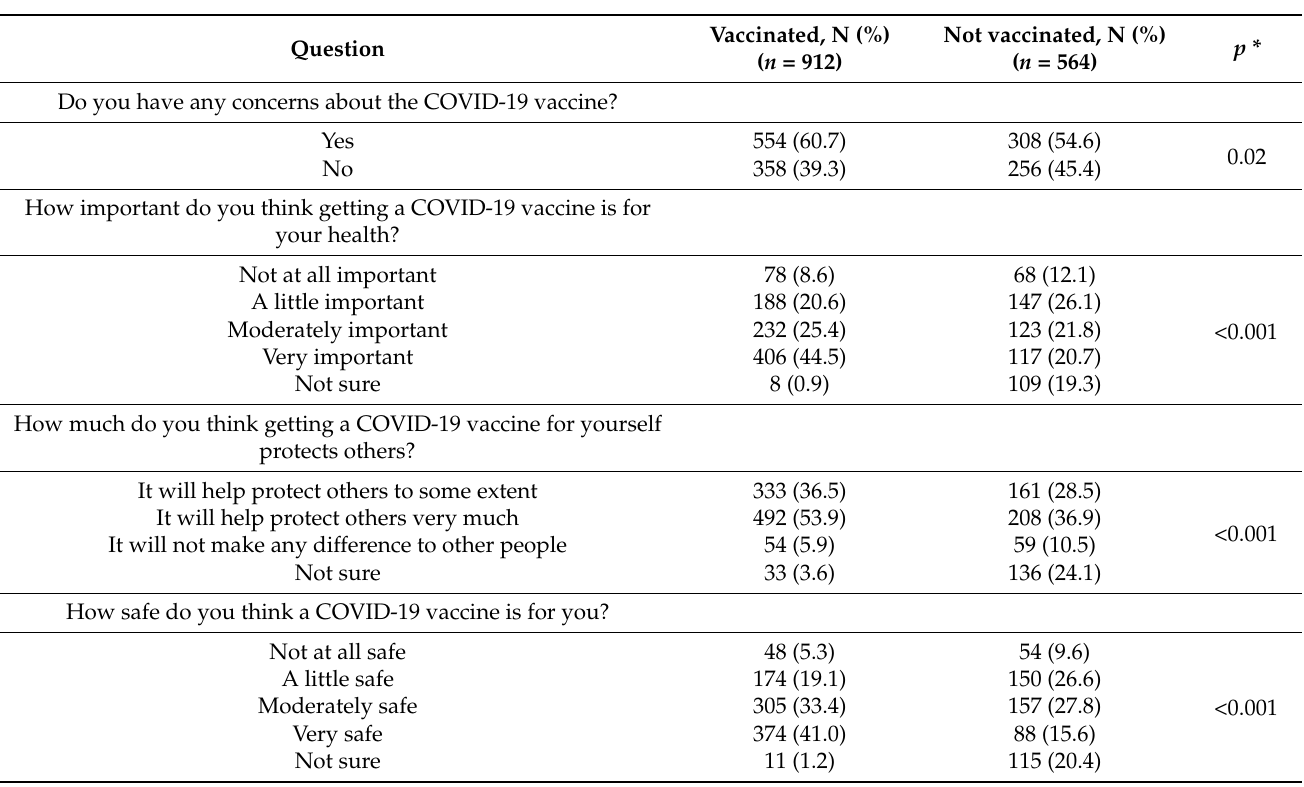
Table 3. Somali health care workers’ perception of the COVID-19